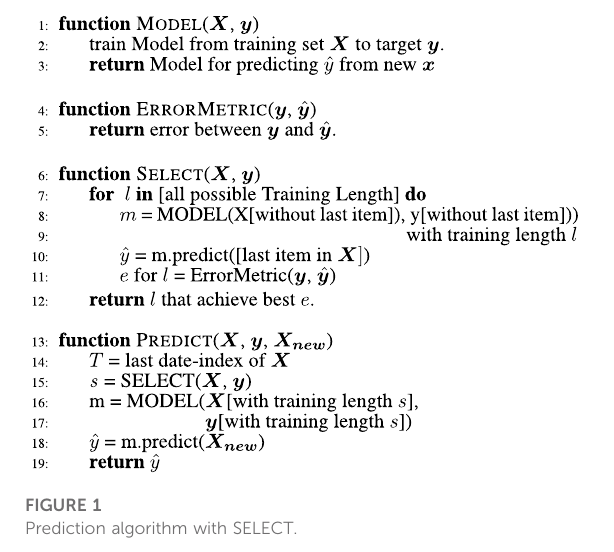
FIGURE 1 Prediction algorithm with SELECT.